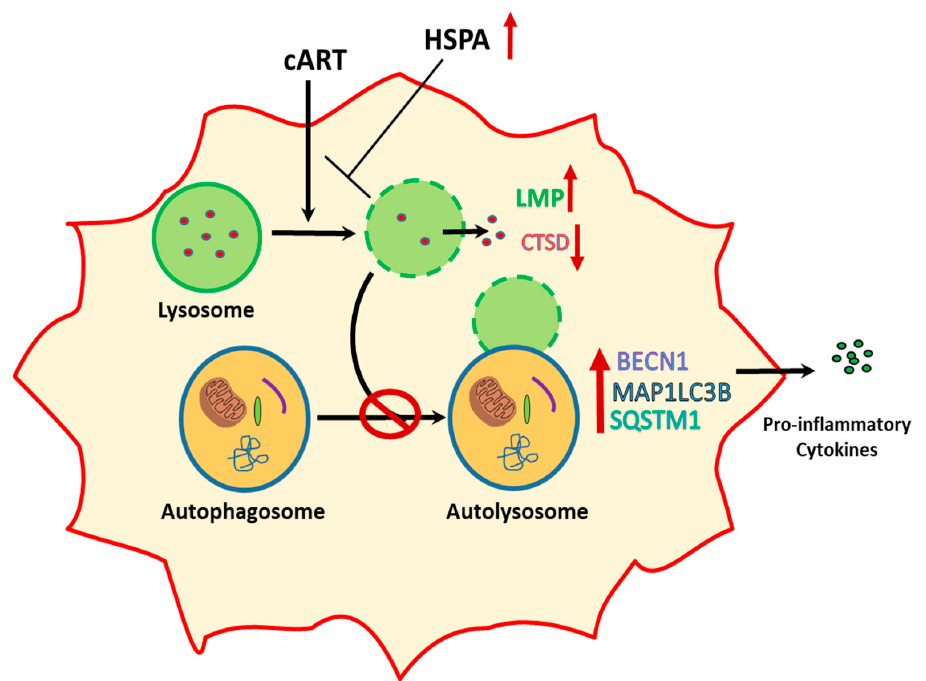
Figure 7. Schematic depicting cART-mediated activation of microglia involving lysosomal and